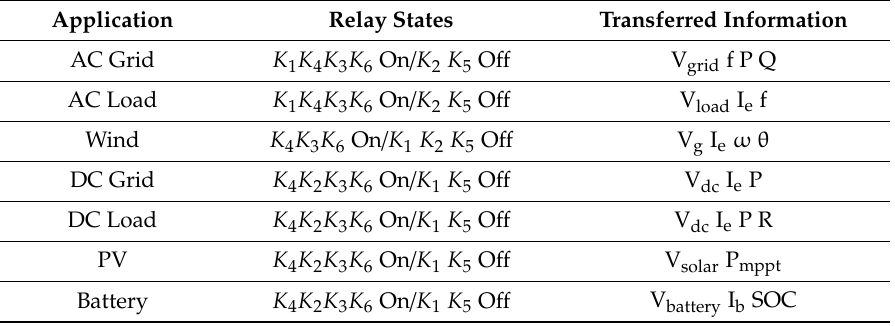
Table 2. Application and the corresponding relay states and transferred information of PR.